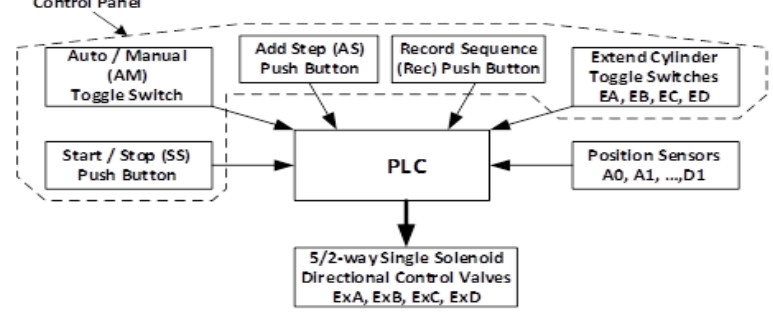
Fig. 2. The PPS Control System Context Diagram.